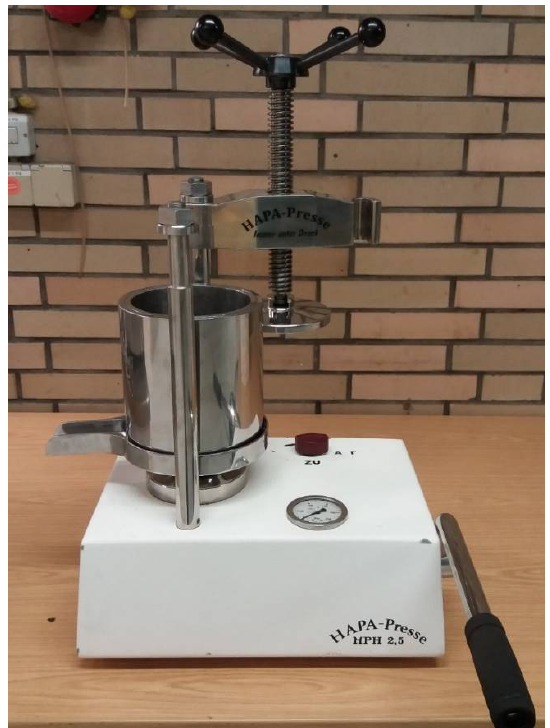
Figure 2. A hydraulic tincture press used for the digestate separation experiments in the labora-